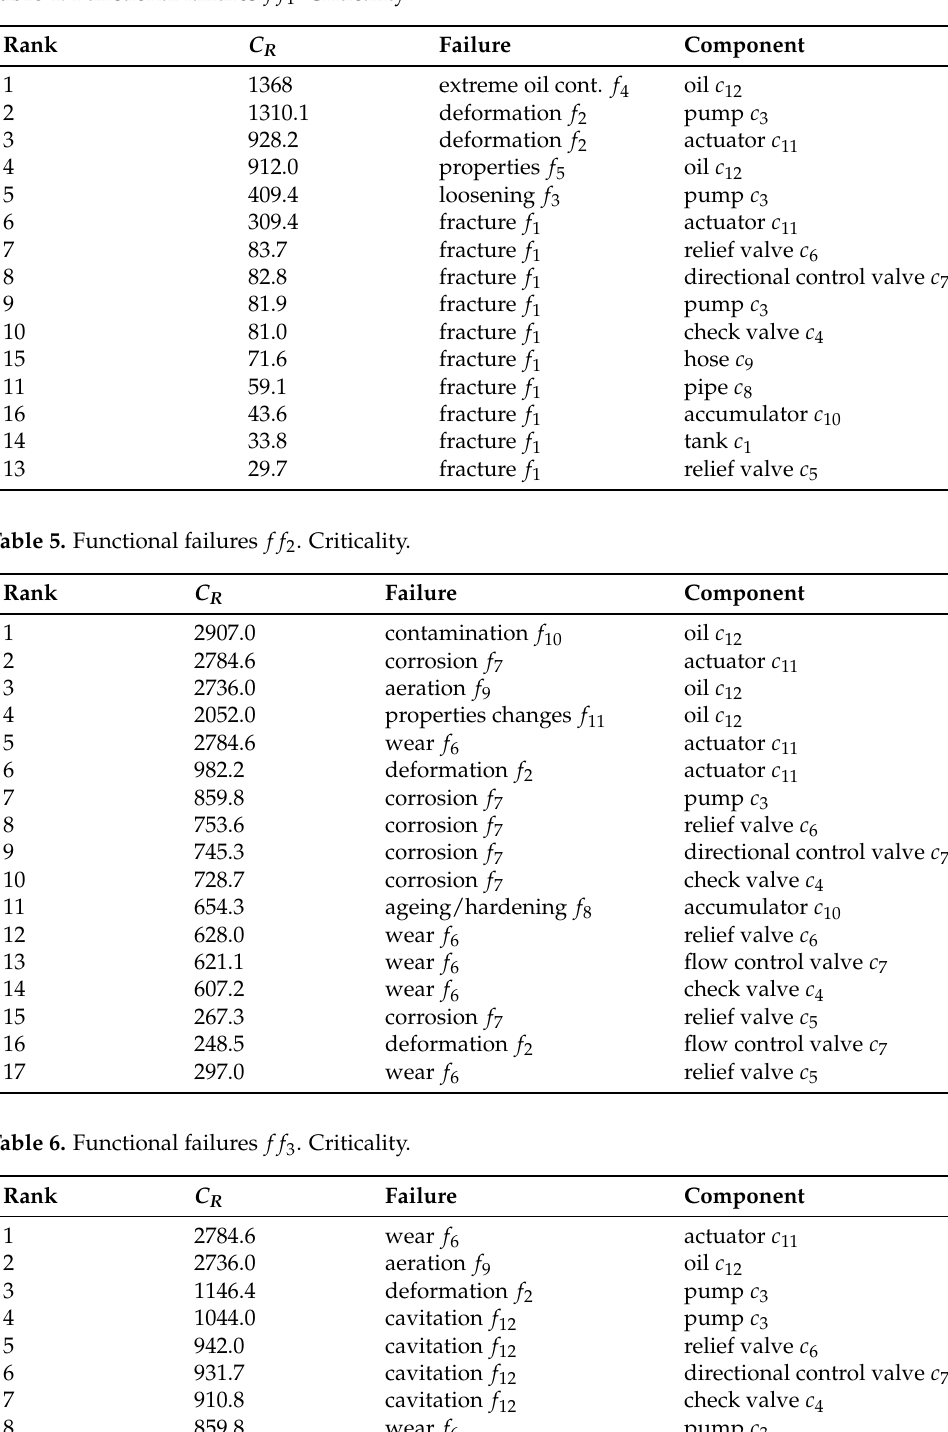
Table 4. Functional failures f f 1 . Criticality.